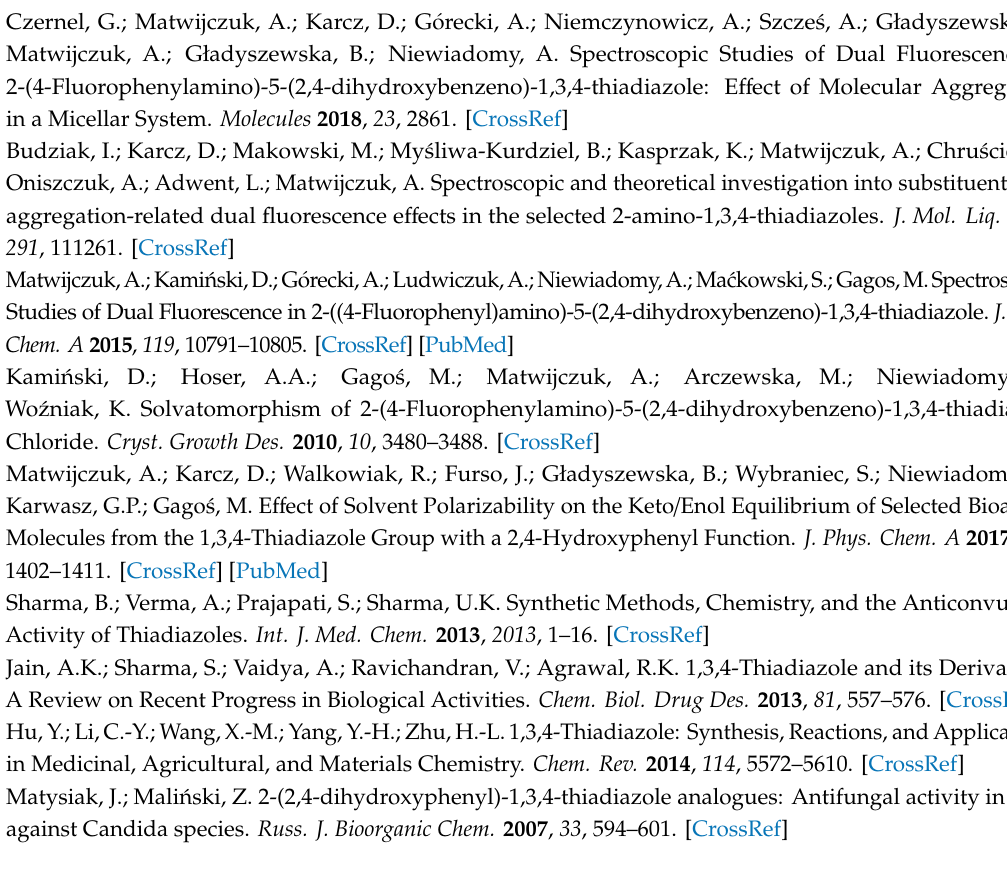
related to the Figure S7. Figure S1. 1H-NMR Spectrum of thiadiazole derivative 1 . Figure S2. 1H-NMR Spectrum of thiadiazole derivative 2 . Figure S3. 1H-NMR Spectrum of thiadiazole derivative 3 . Figure S4. 13C-NMR Spectrum of thiadiazole derivative 1 . Figure S5. 13C-NMR Spectrum of thiadiazole derivative 2 . Figure S6. 13C-NMR Spectrum of thiadiazole derivative 3 . Figure S7. Crystal Structure of 1 (Atom numeration according to the cif file). Figure S8. Comparison of the IR Spectra of thiadiazole derivatives 1 (top), 2 (middle), and 3 (bottom). Figure S9. Comparison of the IR Spectra of thiadiazole 1 (top), and its corresponding Cu(II) and Zn (II) complexes 4 and 5 (middle and bottom, respectively). Figure S10.Comparison of the IR Spectra of thiadiazole 2 (top), and its corresponding Cu(II) and Zn (II) complexes 6 and 7 (middle and bottom, respectively). Figure S11. UV-Vis spectra of the thiadiazole derivatives 1 – 3 and their corresponding Cu(II) and Zn(II) complexes 4 – 7 . Figure S12. Steady state fluorescence spectra of the thiadiazole derivatives 1 – 3 and their corresponding Cu(II) and Zn(II) complexes 4 – 7 The spectra recorded using the excitation wavelength λ Ex = 290